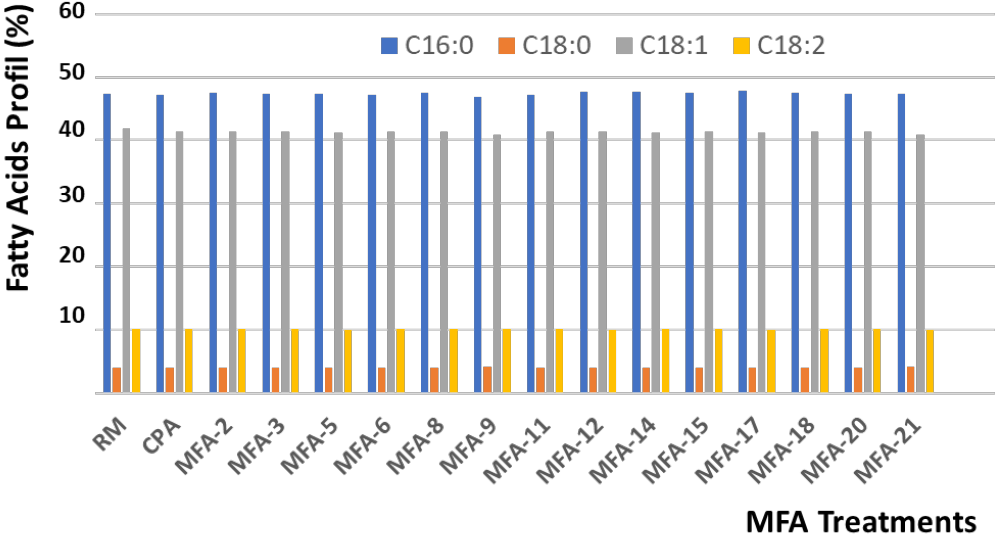
Figure 7. Variation Fatty Acids Profile versus MFA processing parameters.